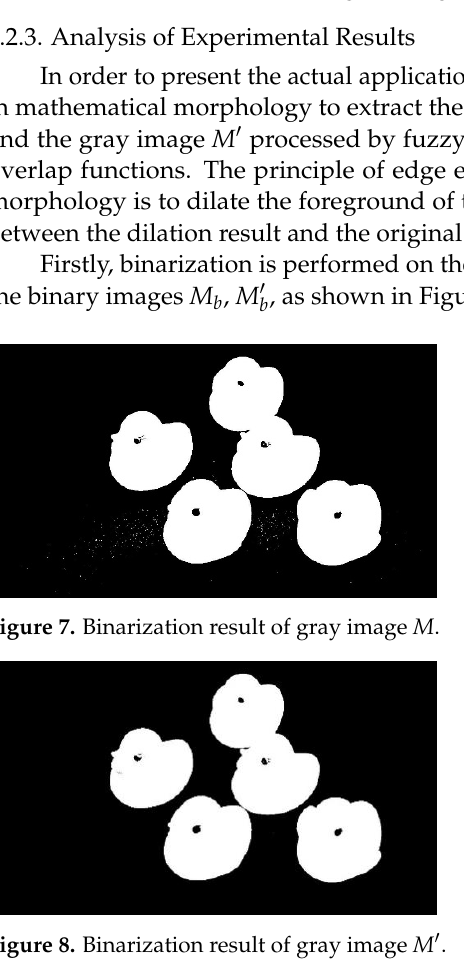
Figure 6. Result of erosion of the original image.